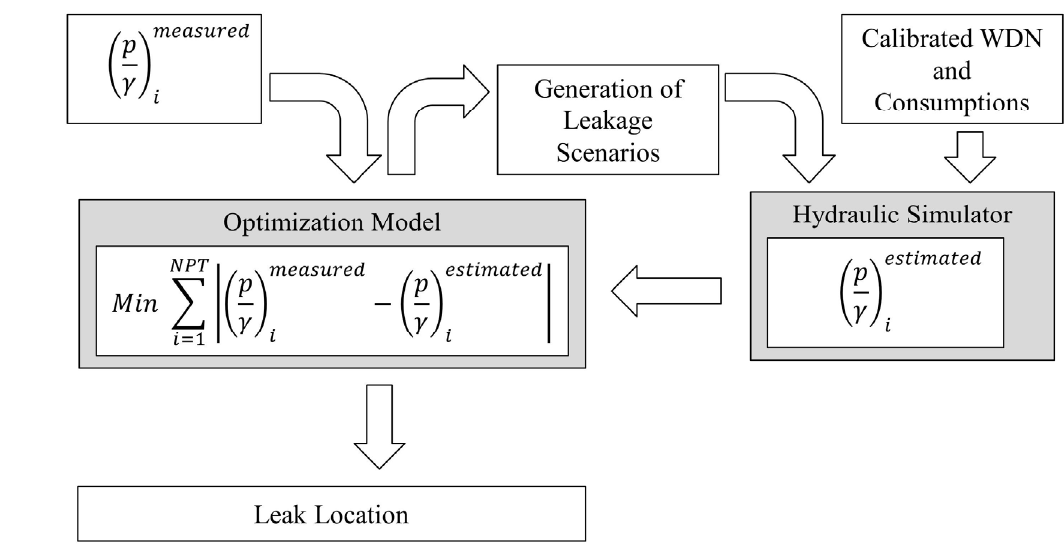
Figure 1. Methodology to predict leak location and